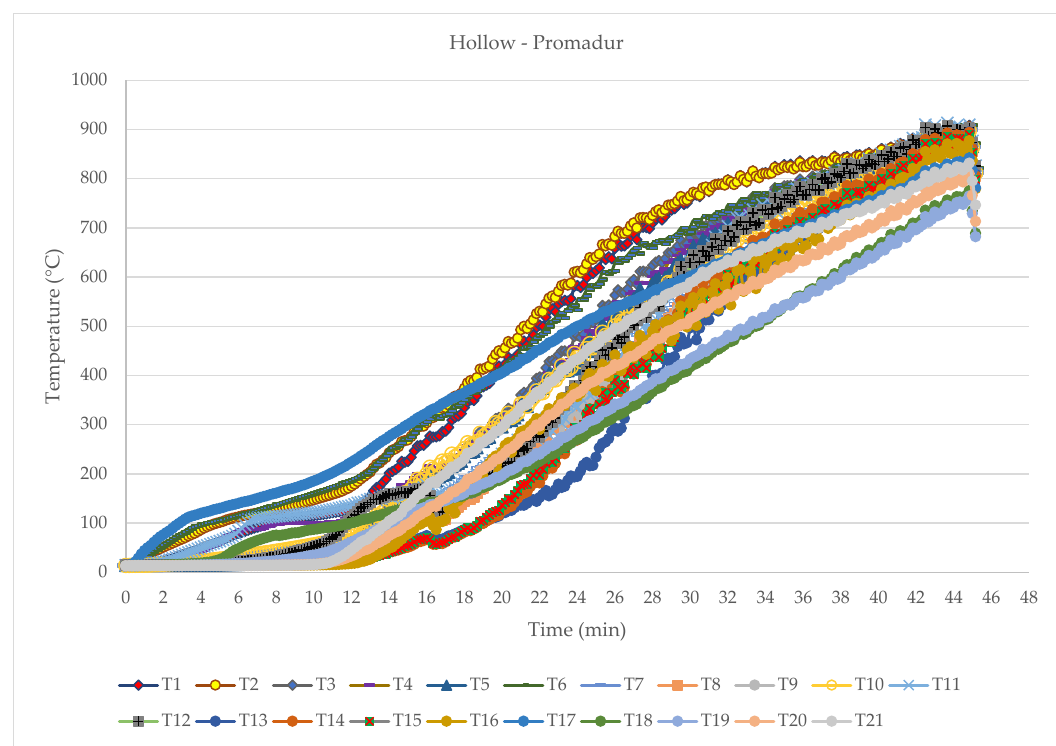
Figure 16. Temperature development diagram—hollow Promadur sample.